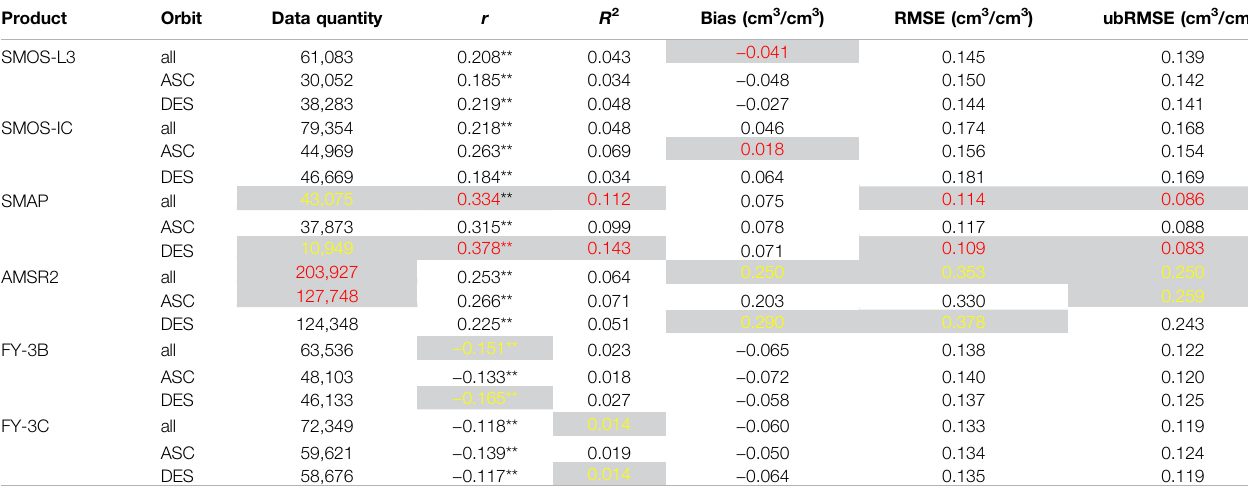
Datainredaretheoptimalparametersofallandeachorbit,anddatainyellowaretheworstparameters.**indicatesthatthematchingdatashowanextremelysigni fi cantcorrelationinthe t -test with a con fi dence interval of 95%.